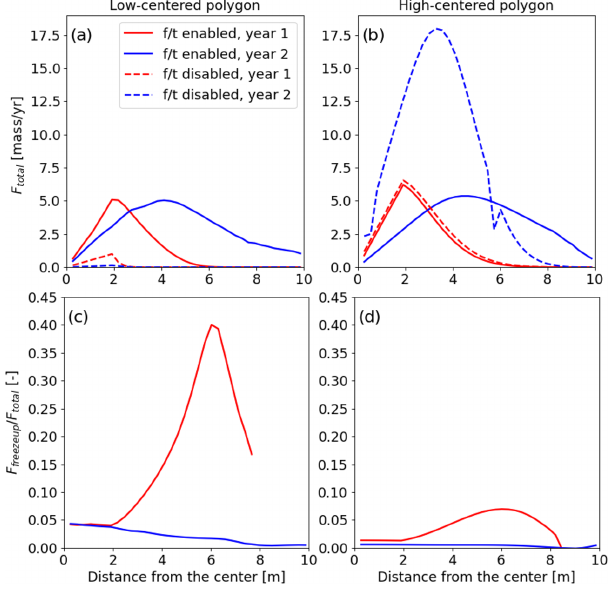
Figure 3. The total flow rate ( F total ) represents the tracer flow rates integrated over the vertical cross-section of the polygon and over the entire year at different distances from the center of the (a) low- centered and (b) high-centered polygon. The proportion of tracer flow rate during the freeze-up period relative to the total flow rate at different distances from the center of the (c) low-centered and (d) high-centered polygon. F freezeup represents the tracer flow rates integrated over the vertical cross-section of the polygon and over the freeze-up period at different distances from the center. The solid red curve corresponds to the year 1 and the solid blue corresponds to the year 2 total flow rates for the freeze–thaw-enabled case. The dashed red curve corresponds to year 1 and the dashed blue corresponds to year 2 total flow rates for the freeze–thaw-disabled case.